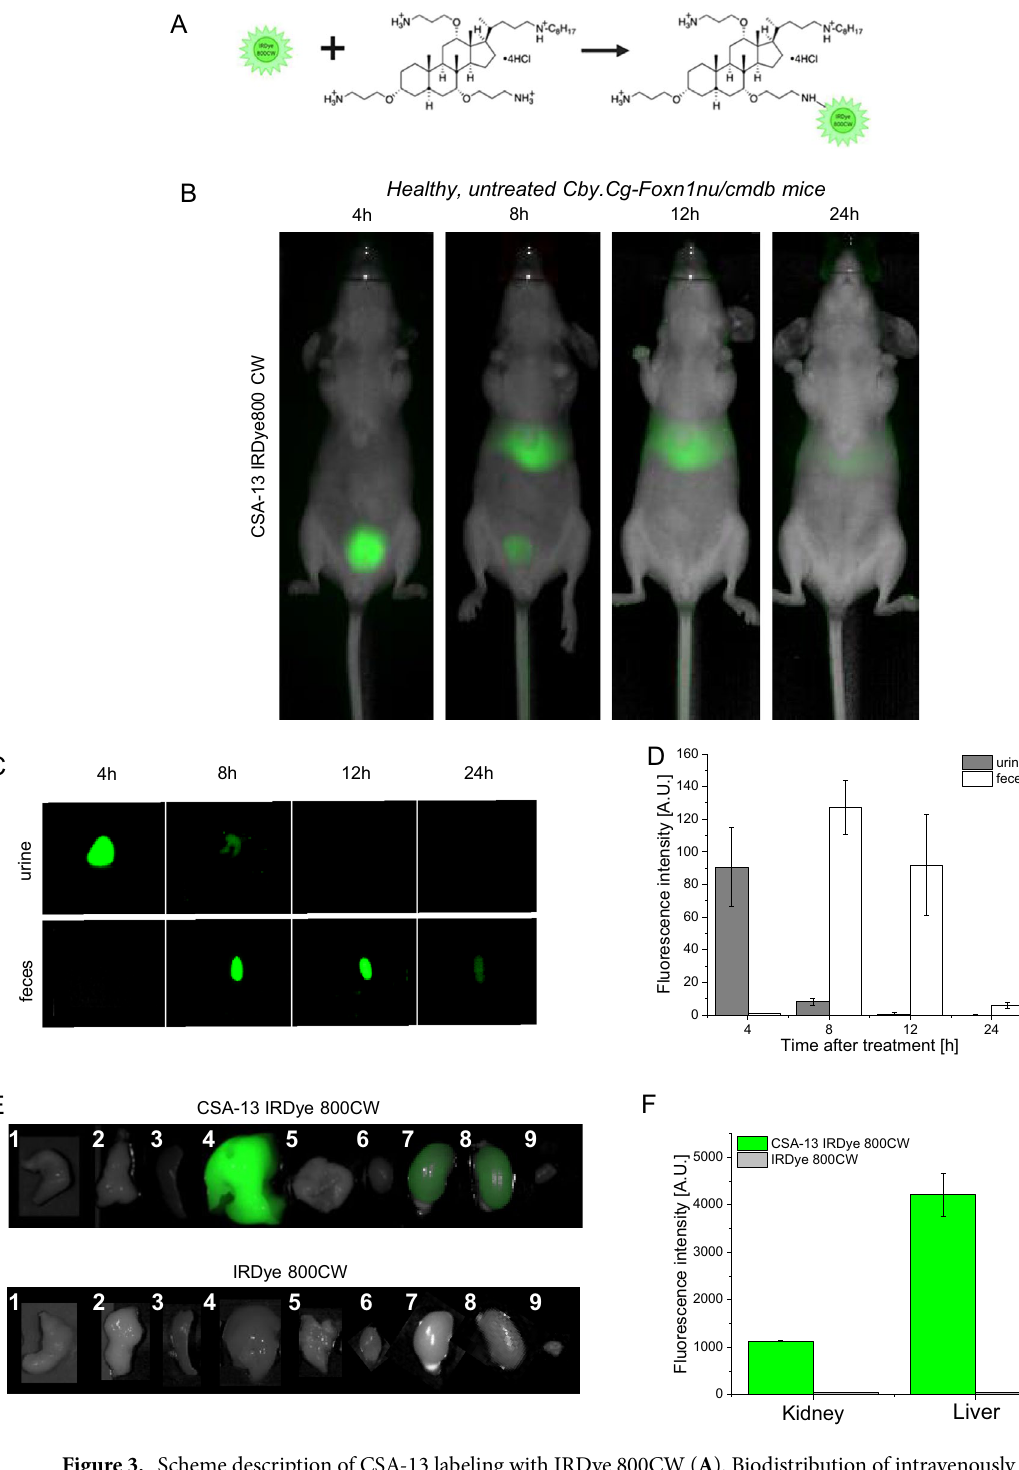
Figure 3. Scheme description of CSA-13 labeling with IRDye 800CW ( A ). Biodistribution of intravenously administrated CSA-13 labeled with IRDye®800CW (CSA-13-IRDye800CW) estimated by fluorescence-based analysis of CSA-13-IRDye800CW-targeted fluorescence signal in healthy, non-infected Cby.Cg-Foxn1nu/cmdb mice (n = 5; group 8) 4, 8, 12 and 24 h post injection of CSA-13 IRDye800CW. Results from representative animals are shown ( B ). Representative scans of urine and feces collected from healthy mice (n = 5; group 8) 4, 8, 12 and 24 h after injection of CSA-13-IRDye800CW ( C ). Presence of labeled CSA-13 in urine and feces was estimated based on fluorescence intensity of collected excreta and presented as mean value ± SEM from all areas of each urine and feces ( D ). Organ uptake of CSA-13-IRDye800CW (group 8) and IRDye800CW (group 9) after 24 h post its administration was estimated based on fluorescence intensity of collected organs (1—stomach, 2— pancreas, 3—spleen, 4—liver, 5—lungs, 6—heart, 7—left kidney, 8—right kidney, 9—bladder) and presented as mean value ± SEM from all areas of each organs ( E , F